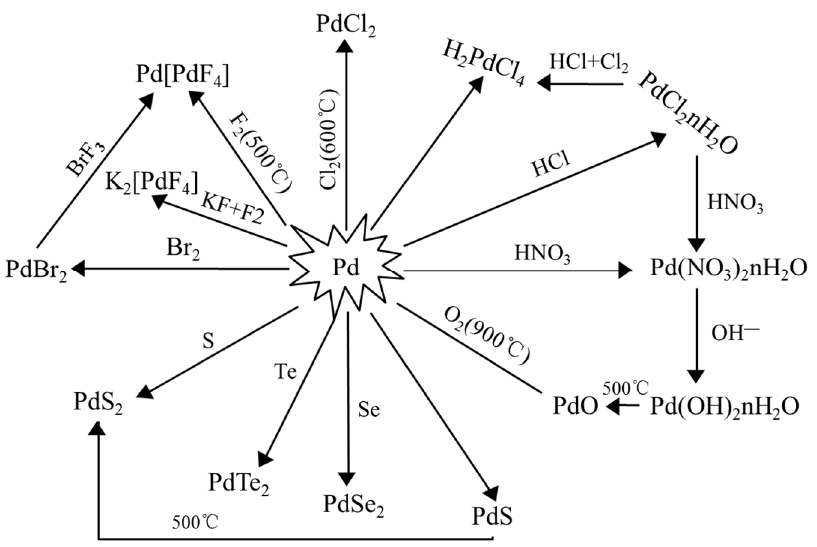
Figure 2. The schematic diagram for the connections between palladium and its compounds. Palladium, located behind hydrogen in the order table of the redox potential of chemical elements, has the most active chemical properties among PGMs. Palladium is hard to oxidize due to its superior chemical stability. Once converted into cationic, palladium turns into a strong oxidizer with a high oxidation potential. Palladium is easily soluble in concentrated nitric acid, hydrogen iodide, aqua regia, and hot potassium cyanide. In addition, hot sulfuric acid, calcium chloride, and molten sodium sulfate also can erode palladium. The corrosion performances of palladium in different corrosive mediums are listed in Table 3 [22]. Table 3. The corrosion performance of palladium.